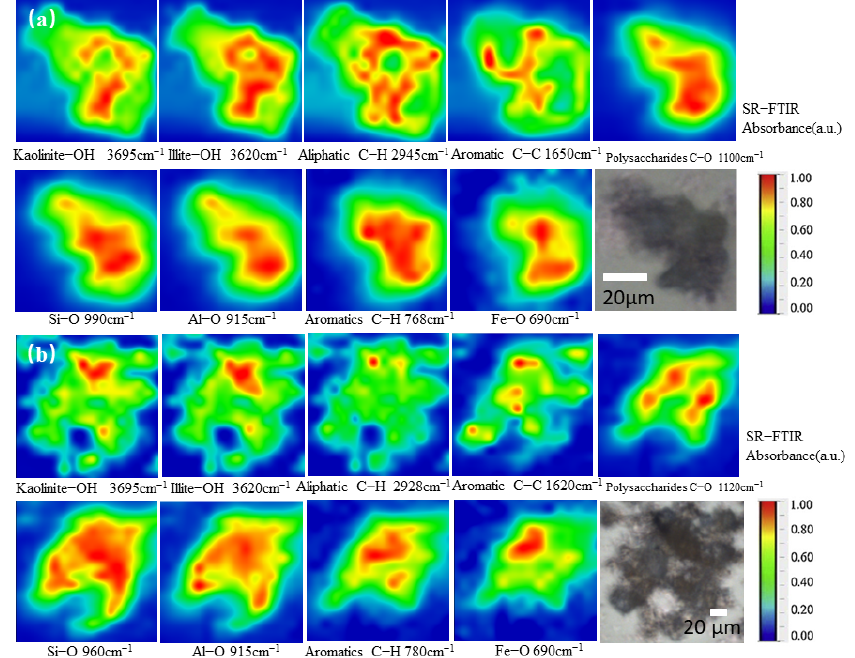
Figure 1. Distribution maps of functional C groups in tea plantation soil detected by SR-based FTIR strategy; ( a ) NPK, ( b ) OM70.